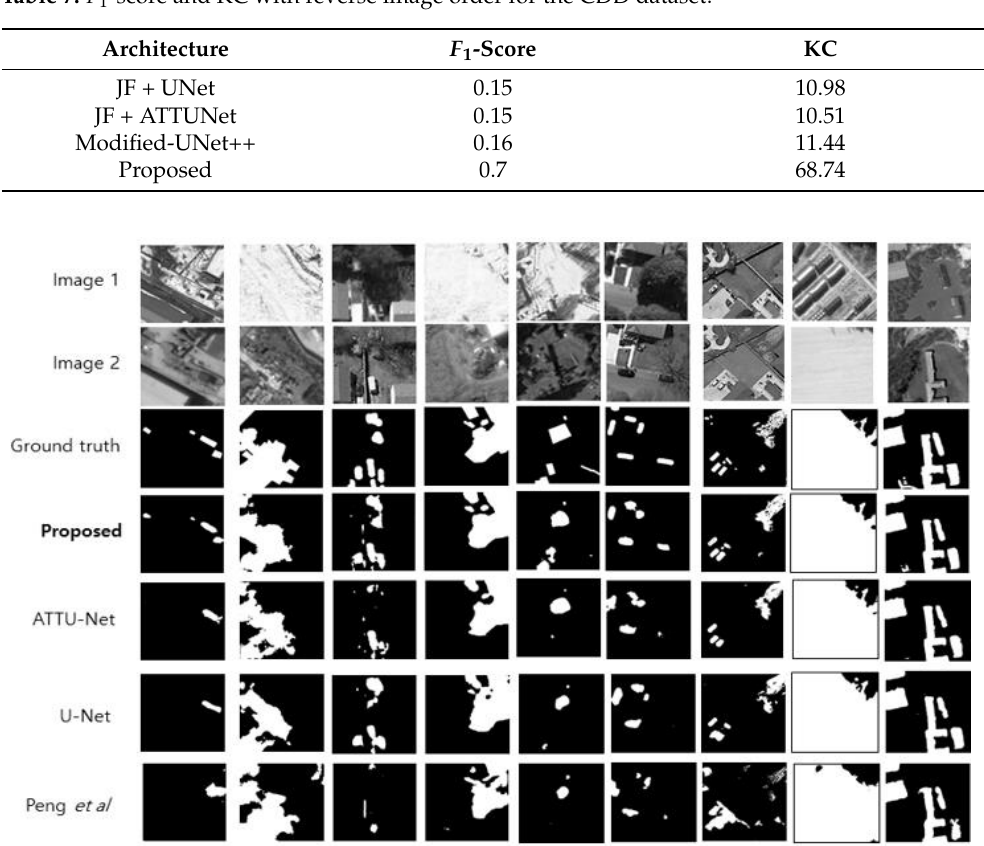
Table 7. F 1 -score and KC with reverse image order for the CDD dataset.